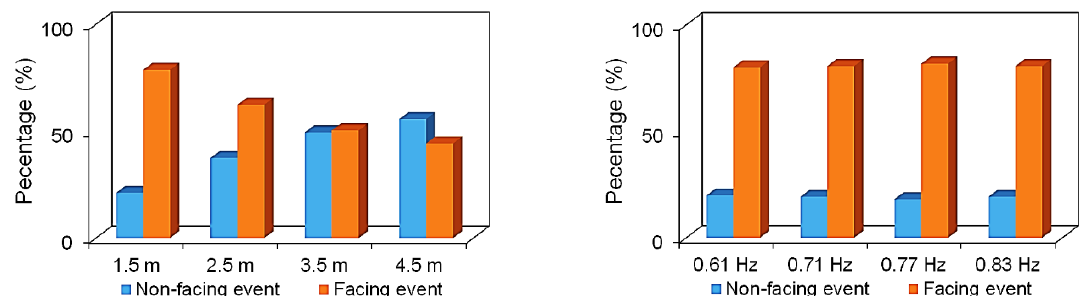
Figure 21. The duration percentages of the non-facing event and the facing event under a random wave with different significant wave height ( left ) and peak frequency ( right ).